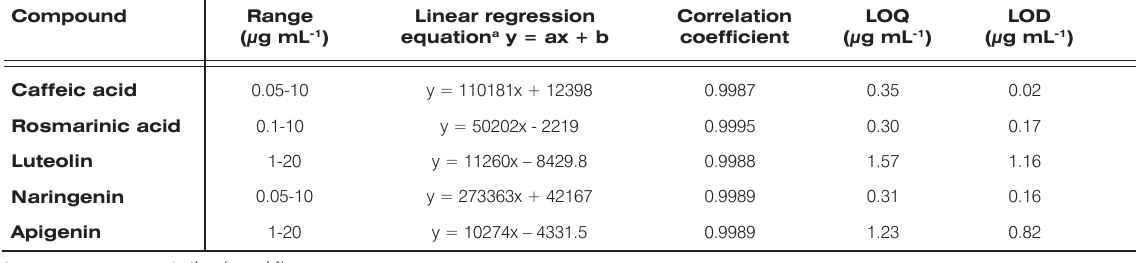
Table 2. Parameters of linear regression for polyphenolic compounds identified in Satureja hortensis